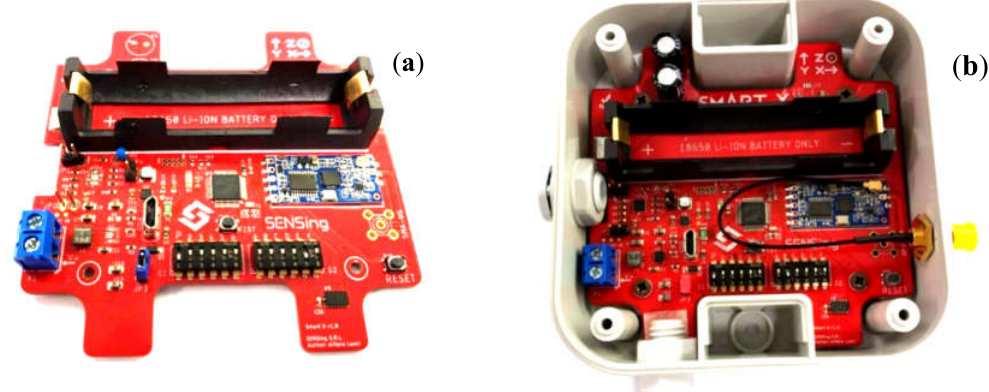
Figure 10. The sensing node prototype: ( a ) multi-layer printed circuit; ( b ) the board with the external case.